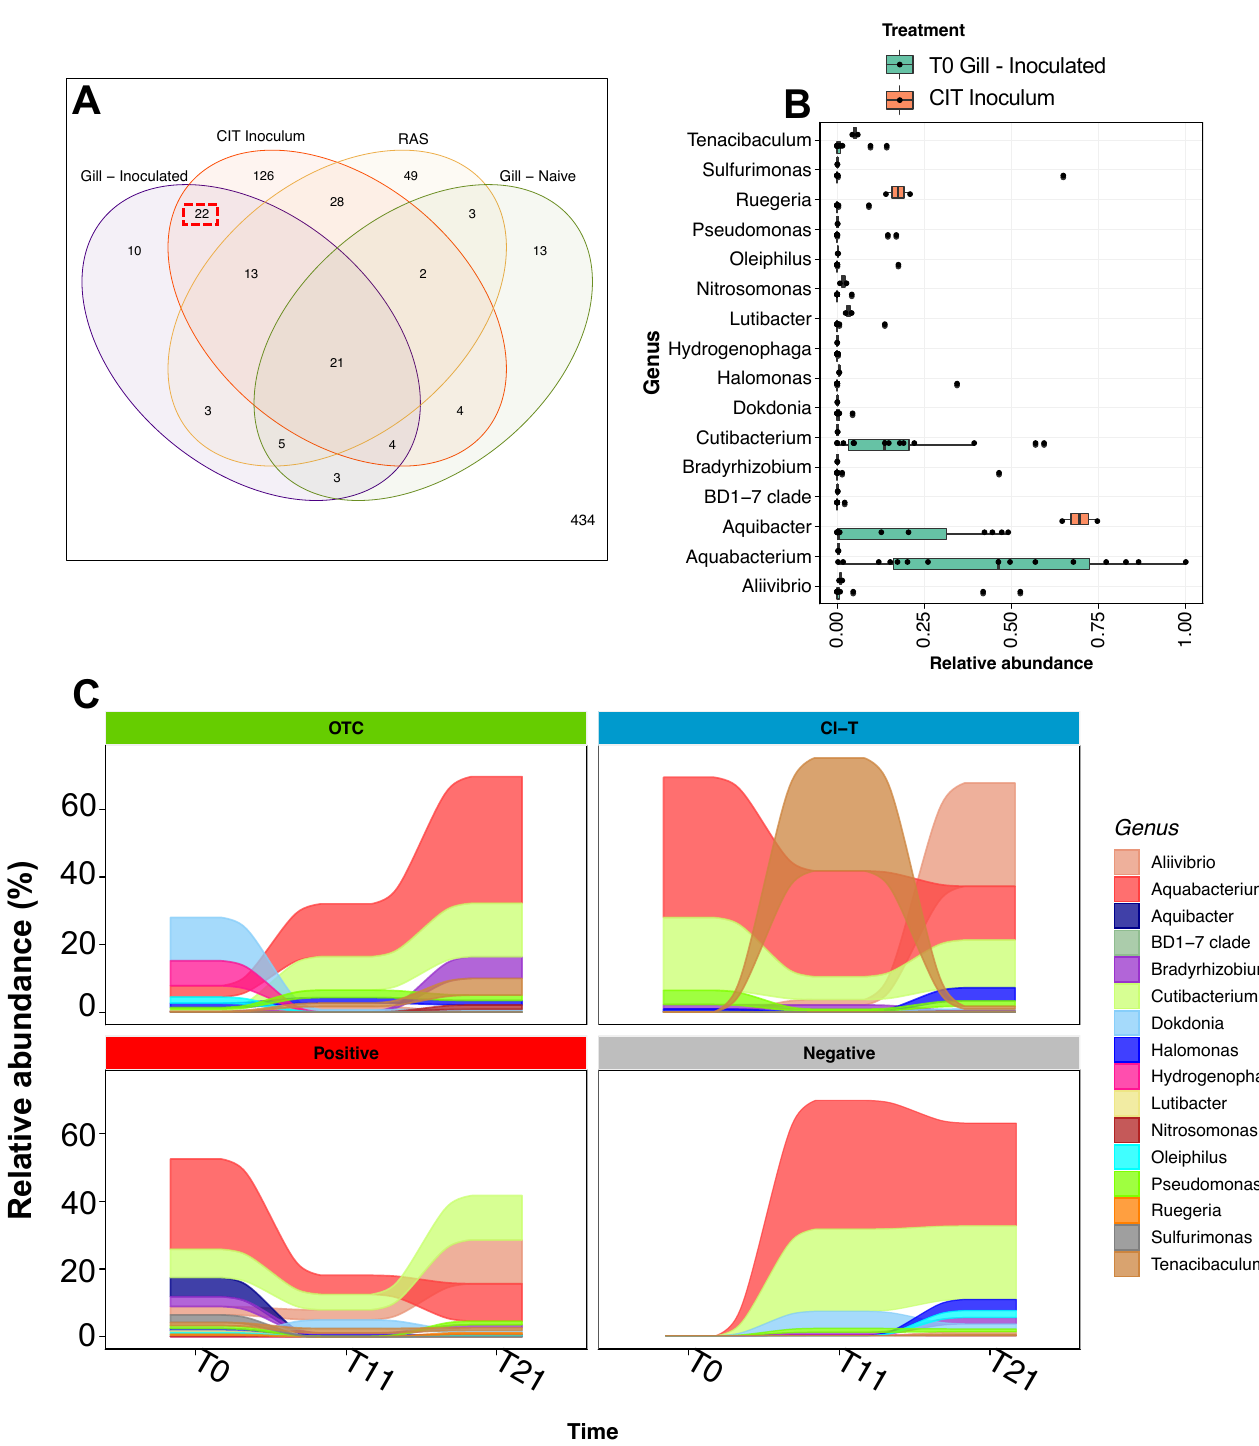
Figure 6. Bacterial taxa associated with AGD sources. ( A ) Venn diagram of shared ASV sequences between the AGD inoculum (CIT), and post inoculated gill (Time 0), naïve gill from the same cohort (Time 0) and the holding tank RAS, showing 22 ASVs shared between AGD inoculum and inoculated gills (Red dashed box). ( B ) Shows relative abundance of genus assigned to shared ASVs in the AGD inoculum and post challenged fish at Time 0. ( C ) Demonstrates the longitudinal relative abundance of representative key genus assignments over the course of the trial. Taxa including Aliivibrio , Tenacibaculum , Cutibacterium and Bradyrhizobium increase toward 21 dpi in AGD positive